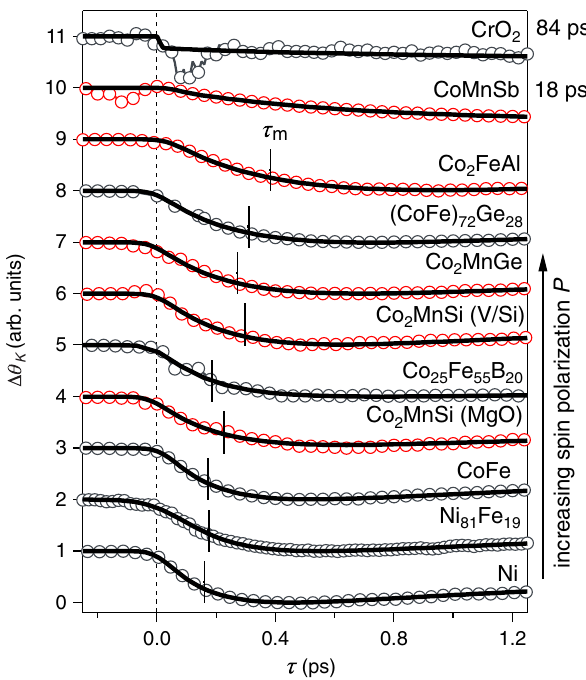
FIG. 2. Ultrafast demagnetization spectra. Femtosecond pump-probe experiments for different materials are sorted by their spin polarization P . Heusler compounds are indicated by red data points. The lines are fits using an analytical function derived from a three-temperature model, and the vertical bar marks the value of (cid:1) m